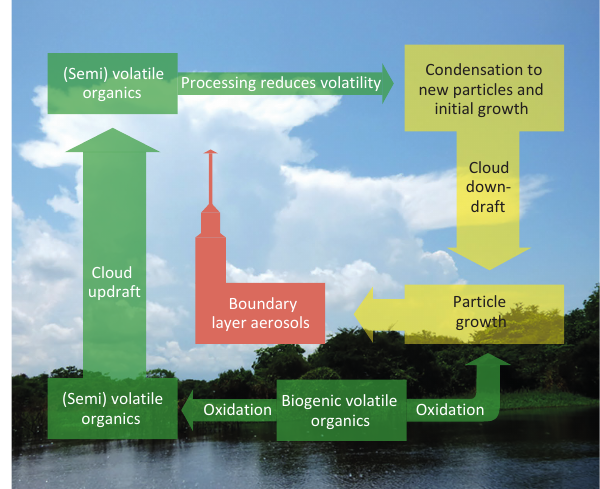
Figure 24. Conceptual model of the aerosol life cycle over the Ama- zon